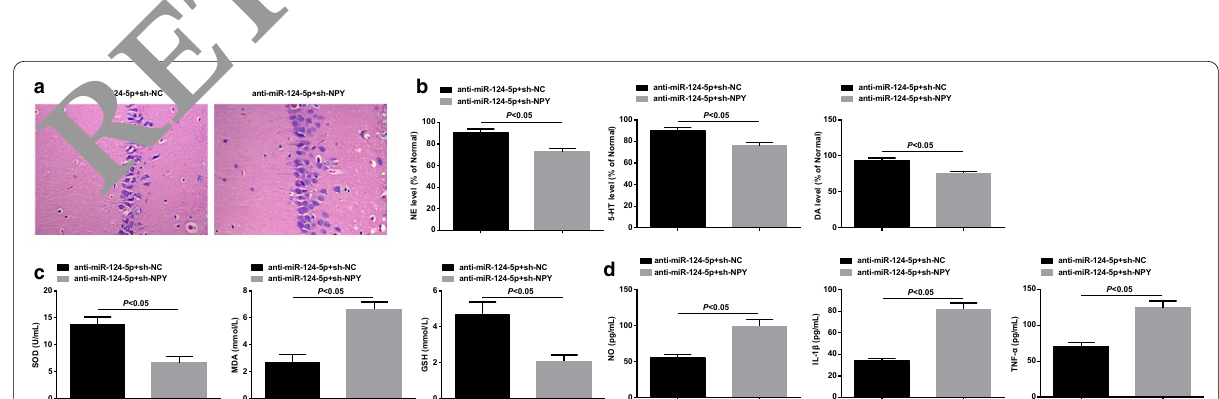
10). Comparisons between two =